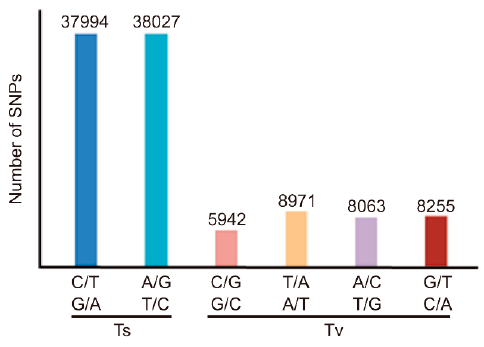
Figure 2. Comparisons of transitions (Ts) and transversions (Tv) in MU1 and Z12.